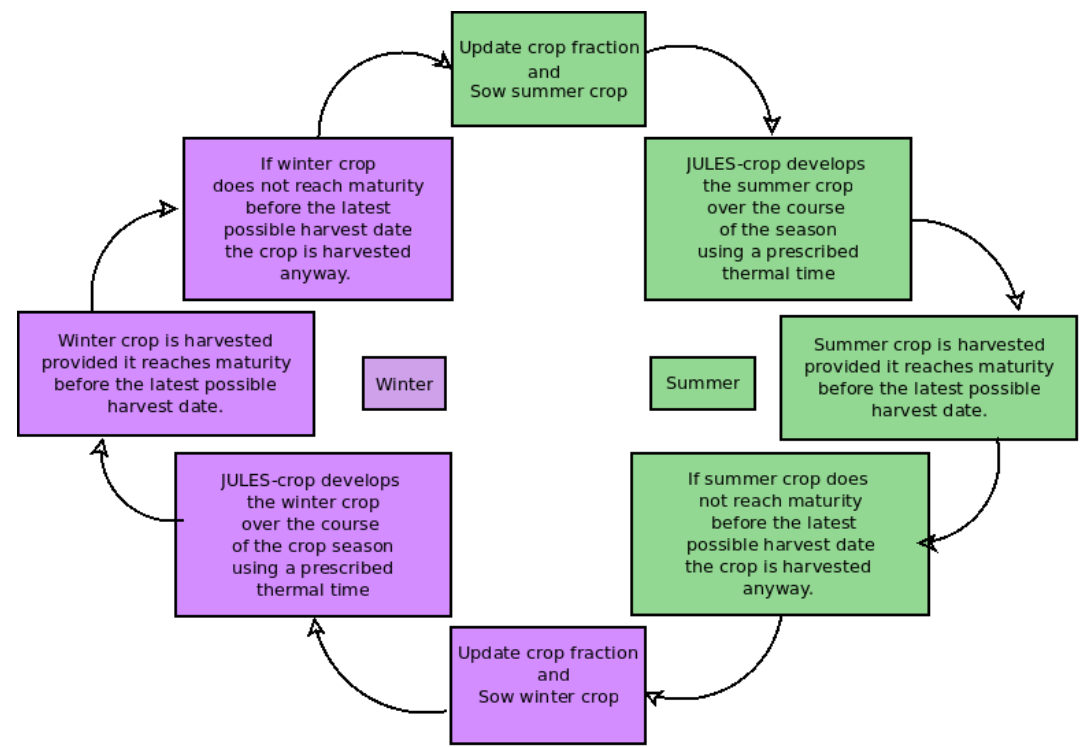
Figure 2. A flowchart showing the sequence followed to carry out the crop rotation in JULES. The first step (top green box) in the sequence is to update the first crop fraction; this occurs as or just before the first crop is